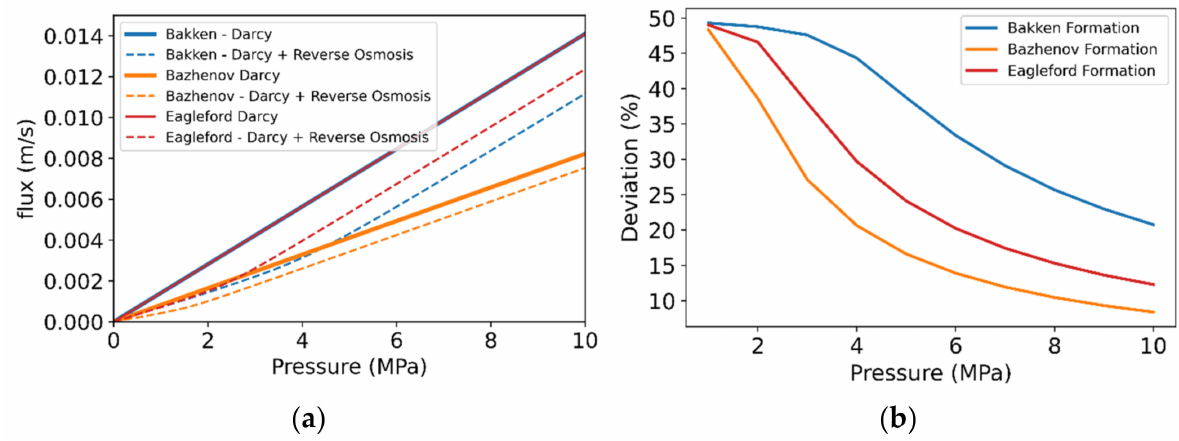
Figure 7. Effect of reverse osmosis on the resultant flow velocity for different tight oil/shale forma- tions. ( a ) Resultant flow velocity proportionality to pressure difference with and without the effect of reverse osmosis. ( b ) Percentage deviation from the Darcy law for different tight oil